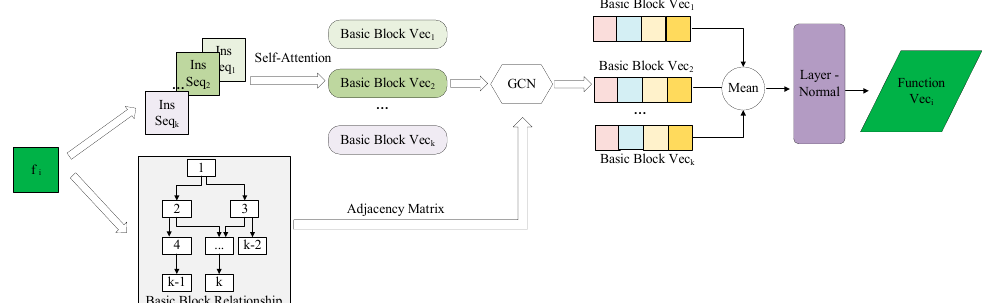
Figure 5. Embedding network structure that performs two tasks: the extraction of the instruction sequence information based on self-attention and the embedding of the basic block jump adjacency matrix using a graph convolution network (GCN). The generated basic block vectors compute the average and then connect to the layer normalization.